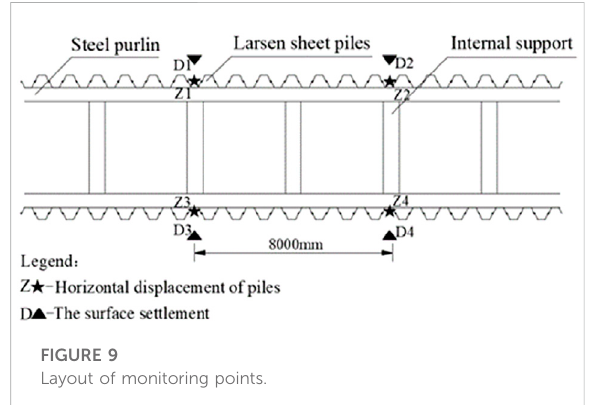
FIGURE 8 Comparison curve of mechanical characteristics of steel- sheet pile pressed into anchor-cable area.